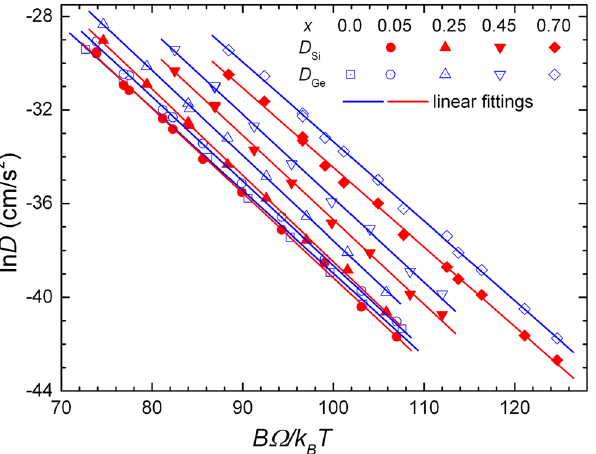
Figure 2. Experimental Si and Ge self-diffusion coefficients in Si 1 − x Ge x alloys at different concentrations x , as a function of the quantity BΩ / k B T . The linear behavior of the fittings ( R 2 ≥ 0.997) implies the validity of the cBΩ model, according to Eq. 12. The experimental data were taken from refs 2 and 9.